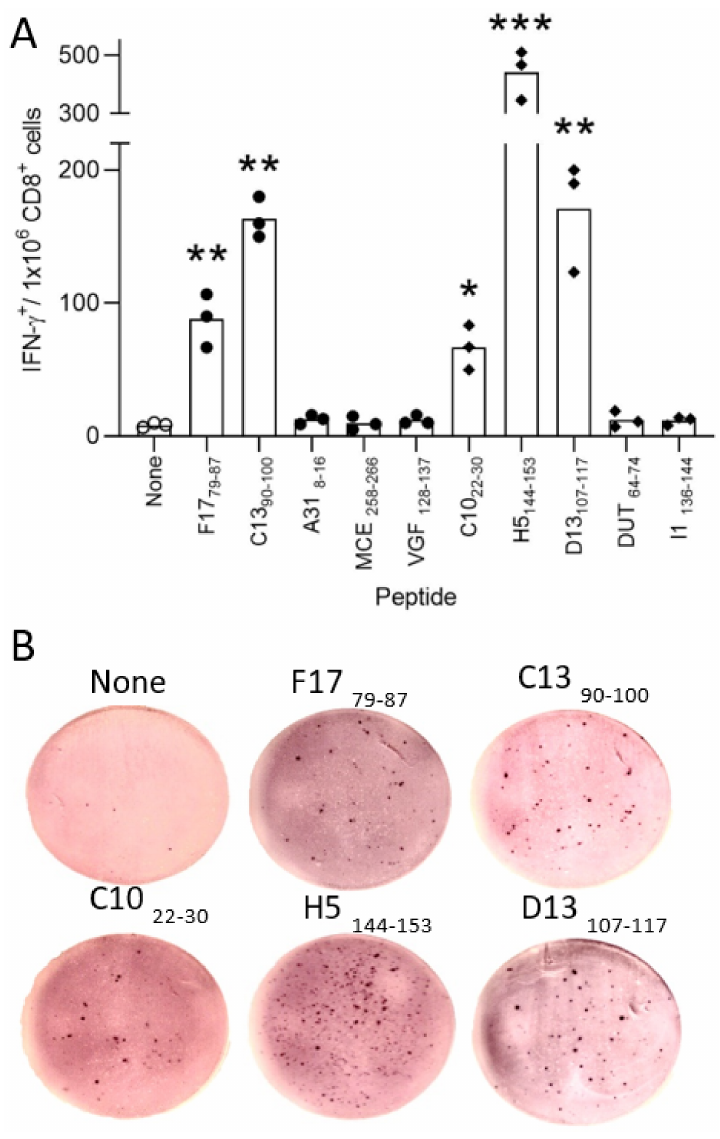
Figure 3. The immunogenicity of VACV-derived HLA-B*27:05-restricted peptides in the HLA class I transgenic mice. ( A ) HLA-B*27:05 target cells that were pre-pulsed with the indicated VACV-synthetic peptides and were analyzed by ELISPOT for CD8 + T cell activation with VACV-specific splenocytes obtained from HLA-B*27:05 transgenic mice immunized for 7 days (acute response) post VACV infection. The results are calculated as the mean of three independent experiments ± SD. Significant p values (* < 0.05; ** < 0.01; and *** < 0.05) of ligands exclusively identified in untreated (closed circles) or after acid stripping condition (closed diamonds) versus negative control (open circles) is indicated. A representative experiment is depicted in ( B